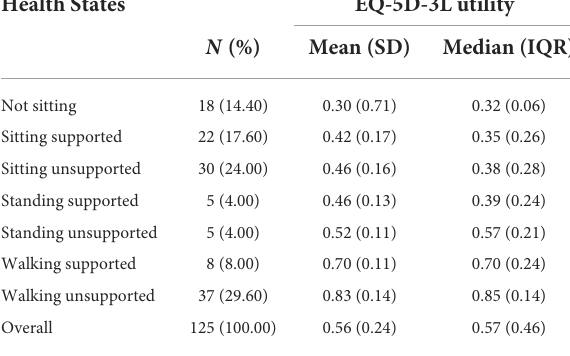
TABLE 7 HSUV derived from Type II and III SMA patients above 16 using EQ-5D-3L ( N = 125). Health